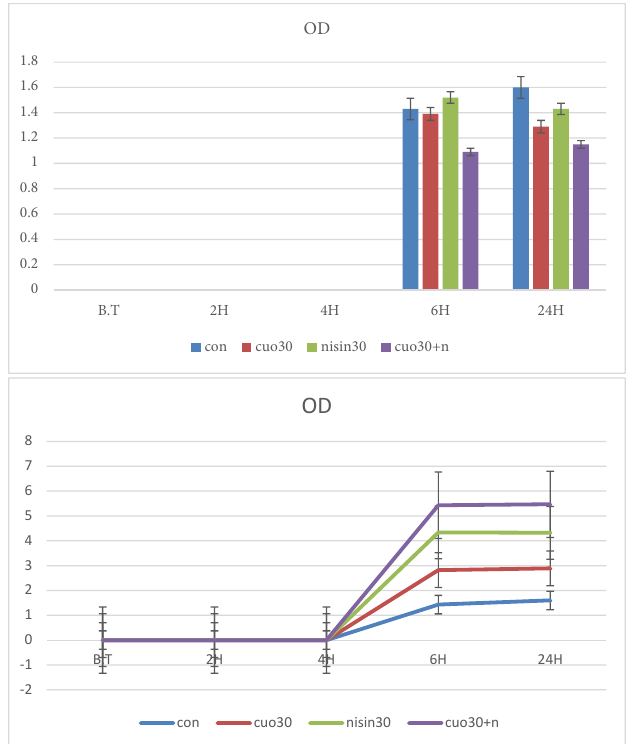
Figure 1: Electrophoresis results of non-conjugated products obtained from RAPD-PCR